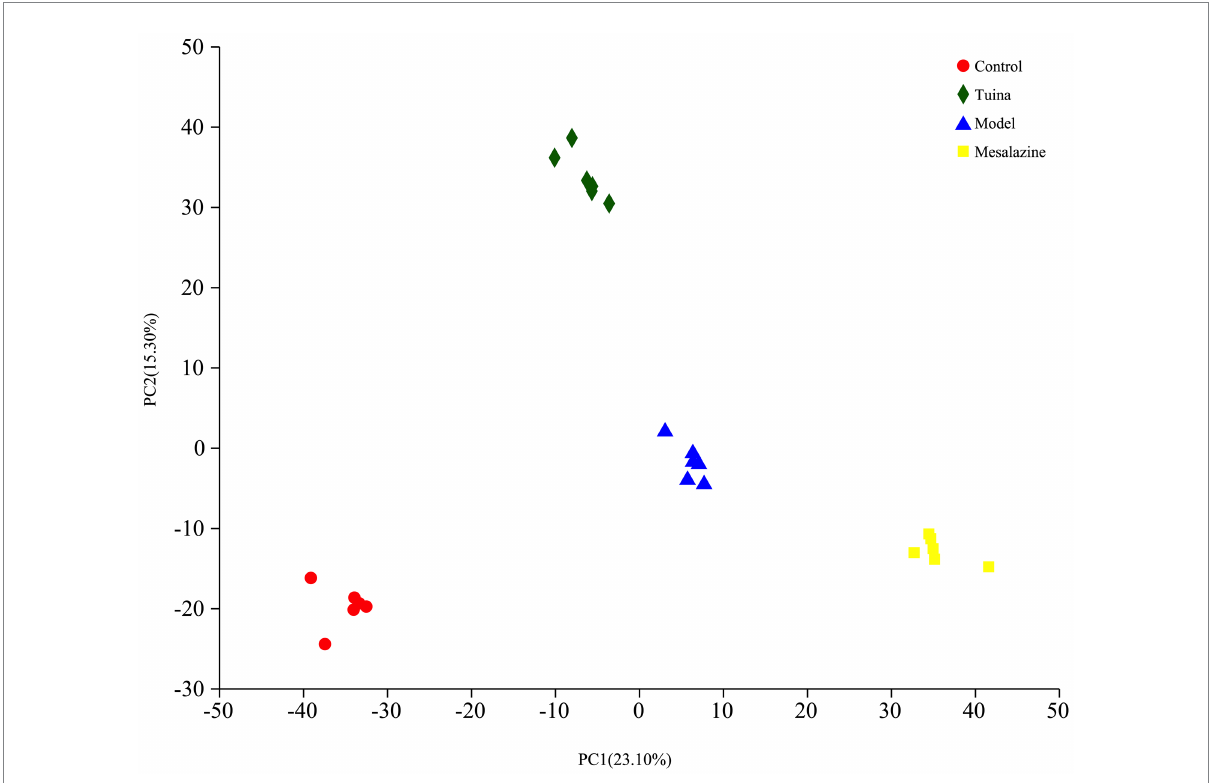
FIGURE 6 PCA analysis and volcano plots. The horizontal coordinate represents PC 1 and the vertical coordinate represents PC